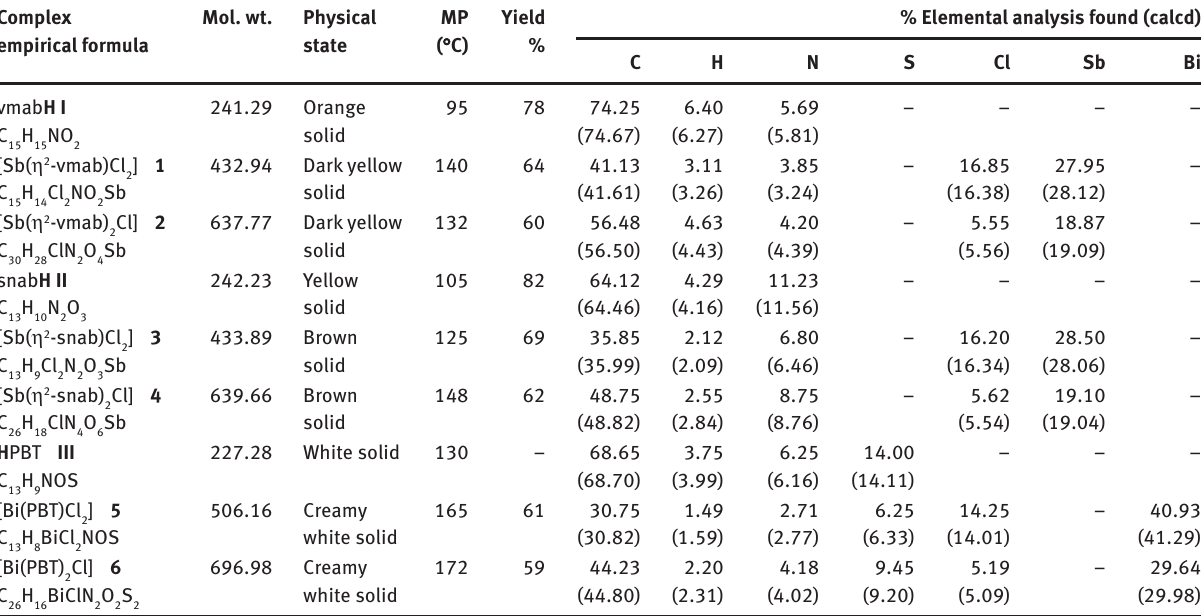
Table 1: Synthetic and analytical details of antimony(III) and bismuth(III) complexes 1–6 . Complex empirical formula